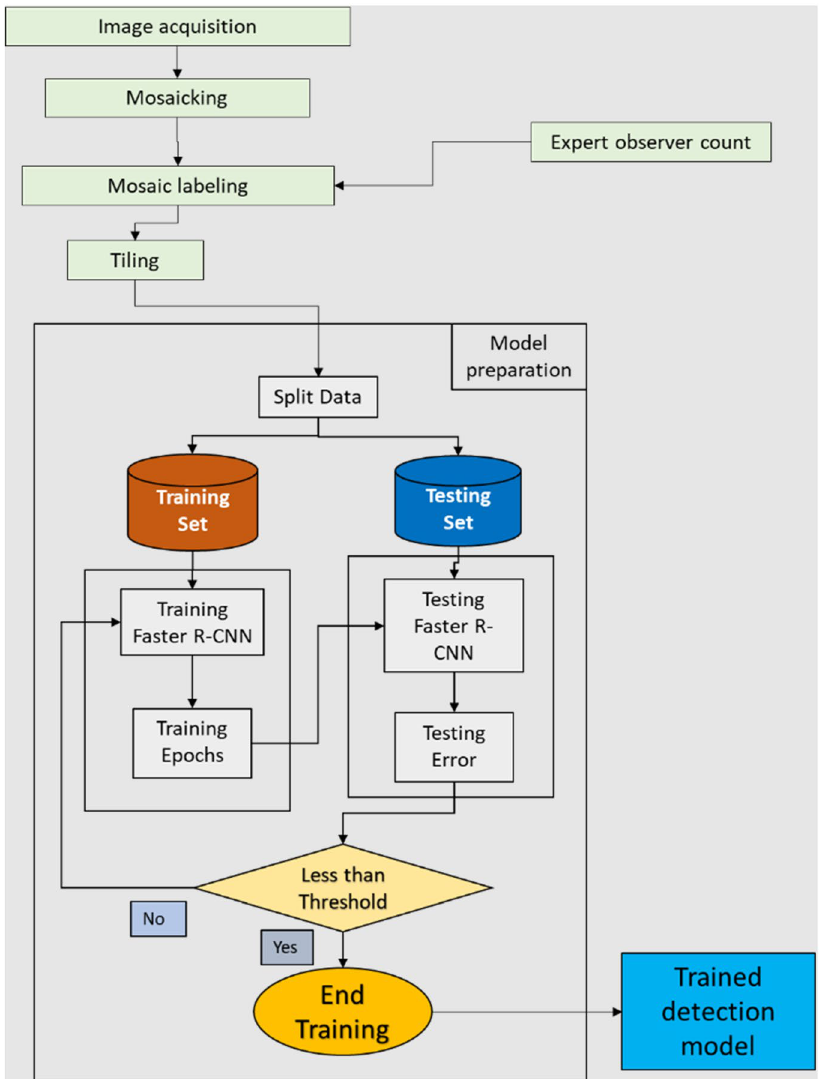
Figure 2. Flowchart of the steps followed to train and test the Faster R-CNN model from the expert observer counts. Results of the trained detection model were then used for comparisons with the experienced observer